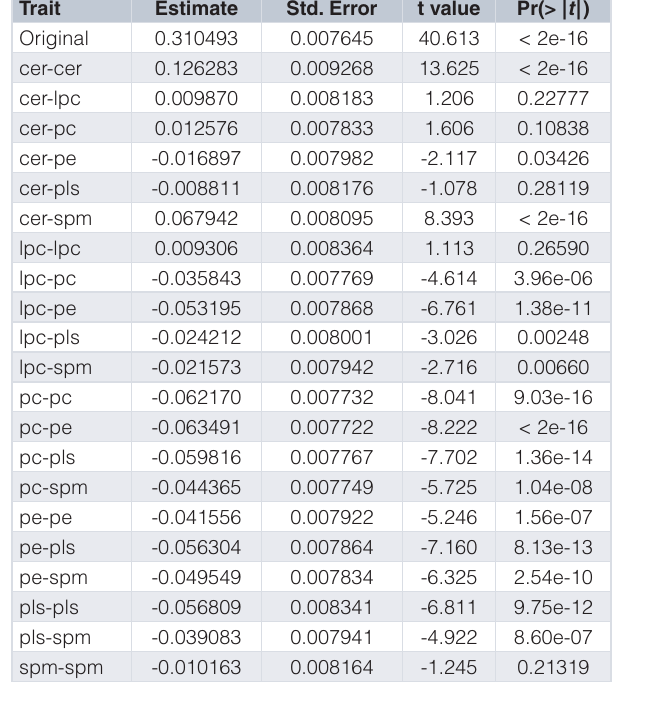
Table S3. Regression analysis of heritability estimates in different traits classes. The label “Original” refers to the average heritability of the original traits (intercept of the model); similarly, “cer-cer” refers to the heritability of ratios involving CER, “cer-lpc” to the heritability of ratios involving CER and LPC, and so on.